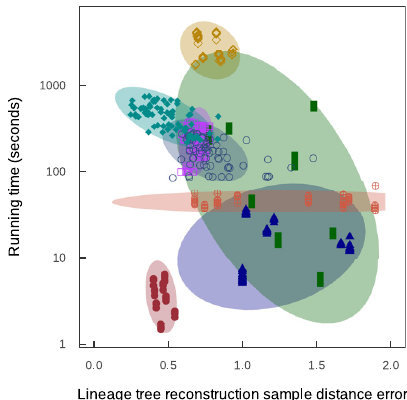
Fig 8. Comparison of methods with respect to running time and lineage tree reconstruction error. For the results obtained from different execution of a method a confidence ellipsoid is calculated and shown as the shaded area around the resulting points. The confidence interval is calculated under the assumption of normal distribution of the points in the two dimensional diagram.